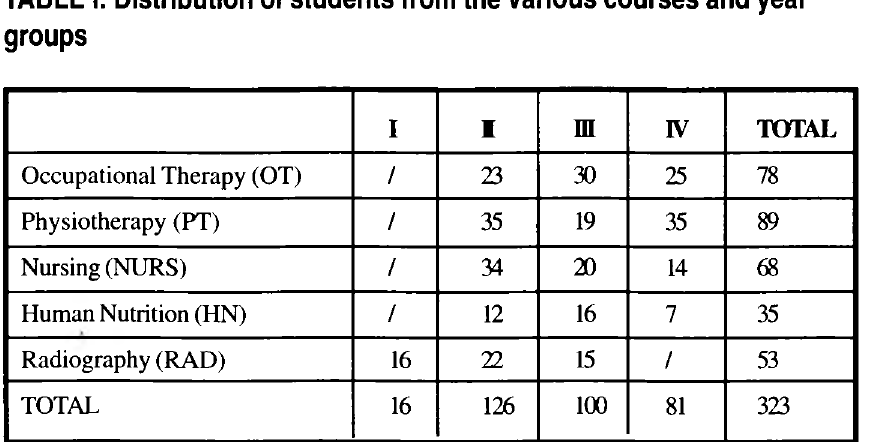
TABLE I: Distribution of students from the various courses and